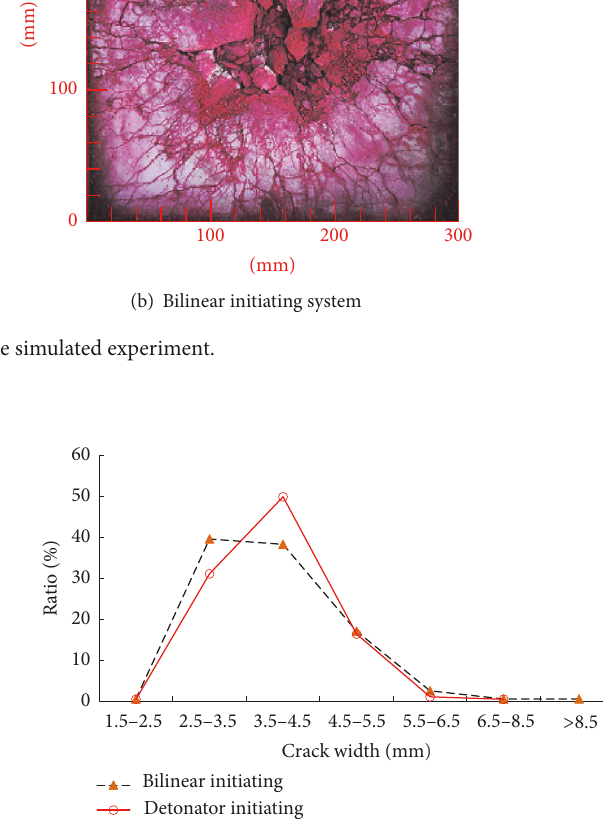
Figure 6: Ratios of crack widths from the physically simulated